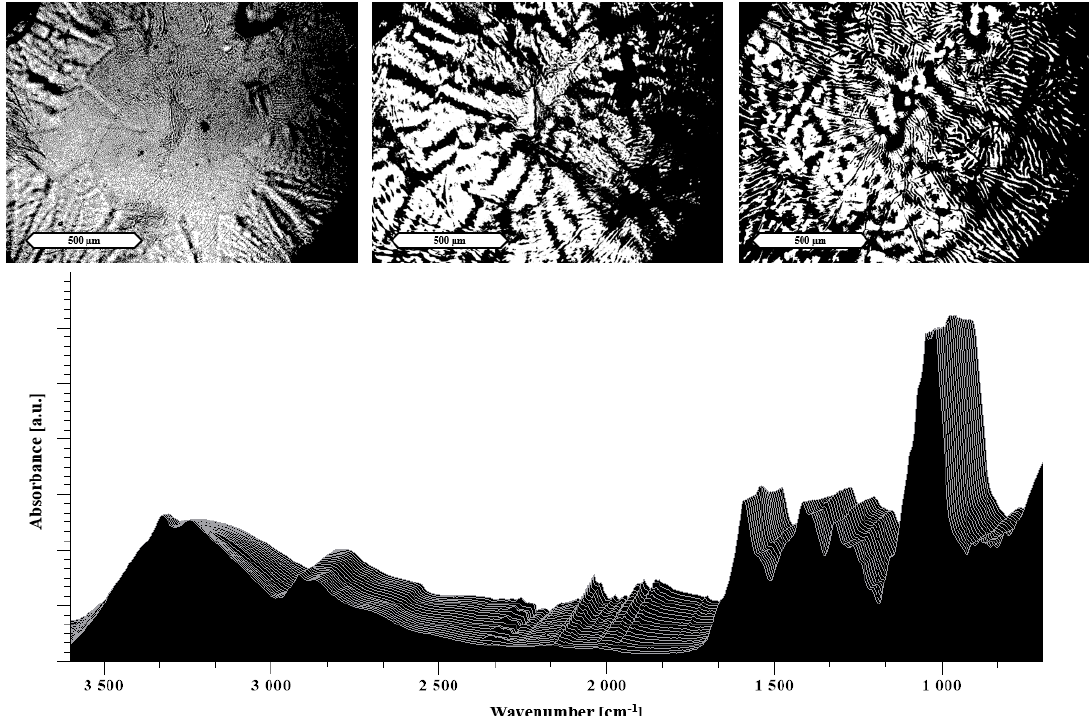
Figure 9. The images at the top show HSM images of 50% meglumine/NaCMC solvent evaporates taken at RT, 90 °C and 130 °C (from left to right). At the bottom, a temperature-resolved FTIR spectrum is shown. The displayed scale bar refers to 500 μ m. Each spectrum was measured at temperatures from 30 °C (measured first in the front) to 130 °C (in the back) by increasing steps of 5 °C.